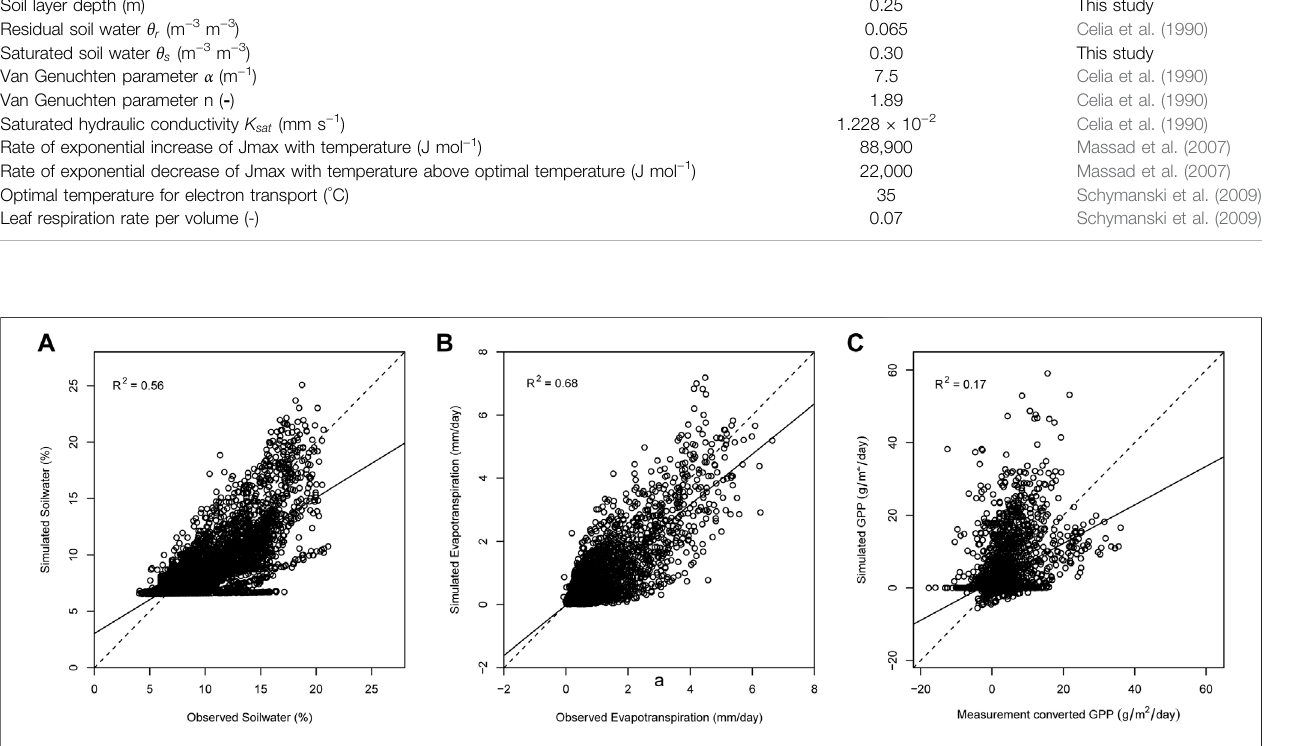
Frontiers in Environmental Science |